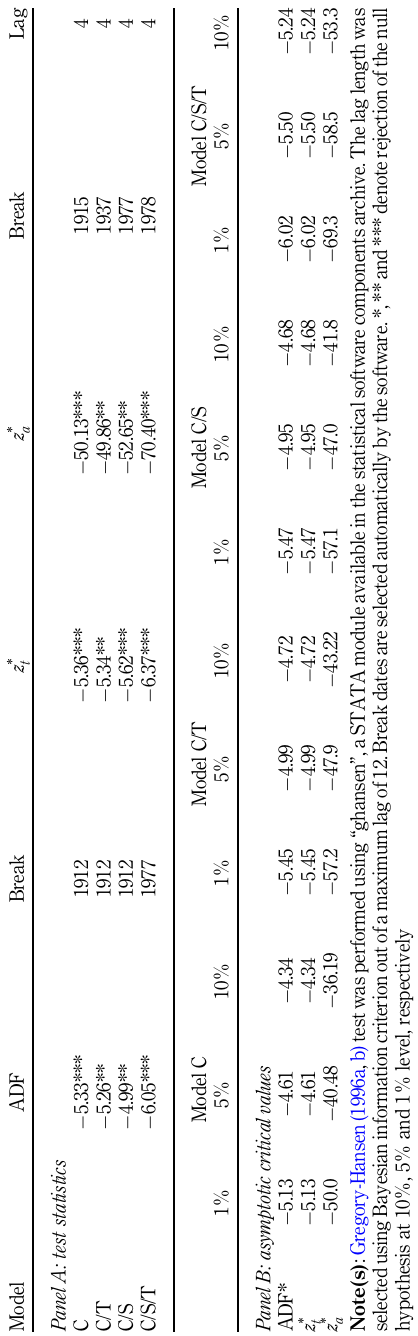
Table 3. Gregory-Hansen (1996a, b) Cointegration test with one